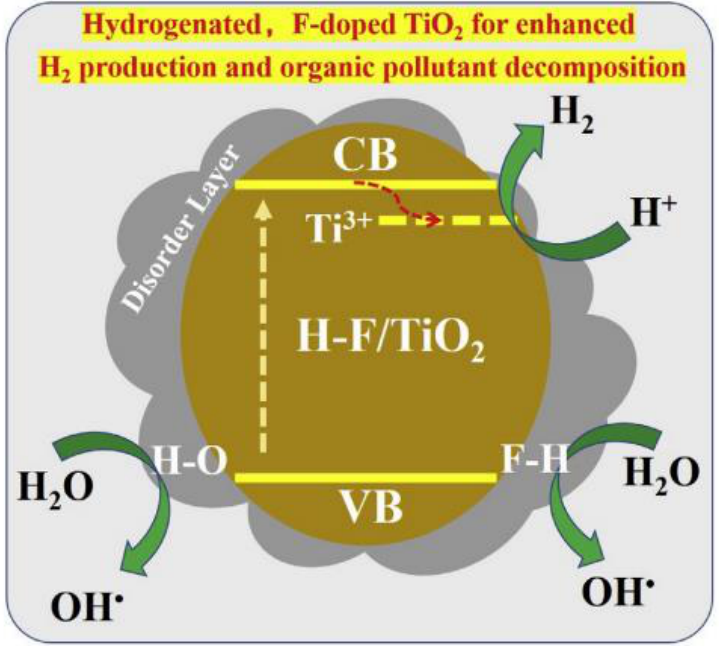
Figure 12. Suggested photocatalytic degradation for H 2 production and dye degradation [180]. Table 9. Summary of halogens-doped TiO 2 photocatalysts synthesized by variety of methods and source precursor materials.